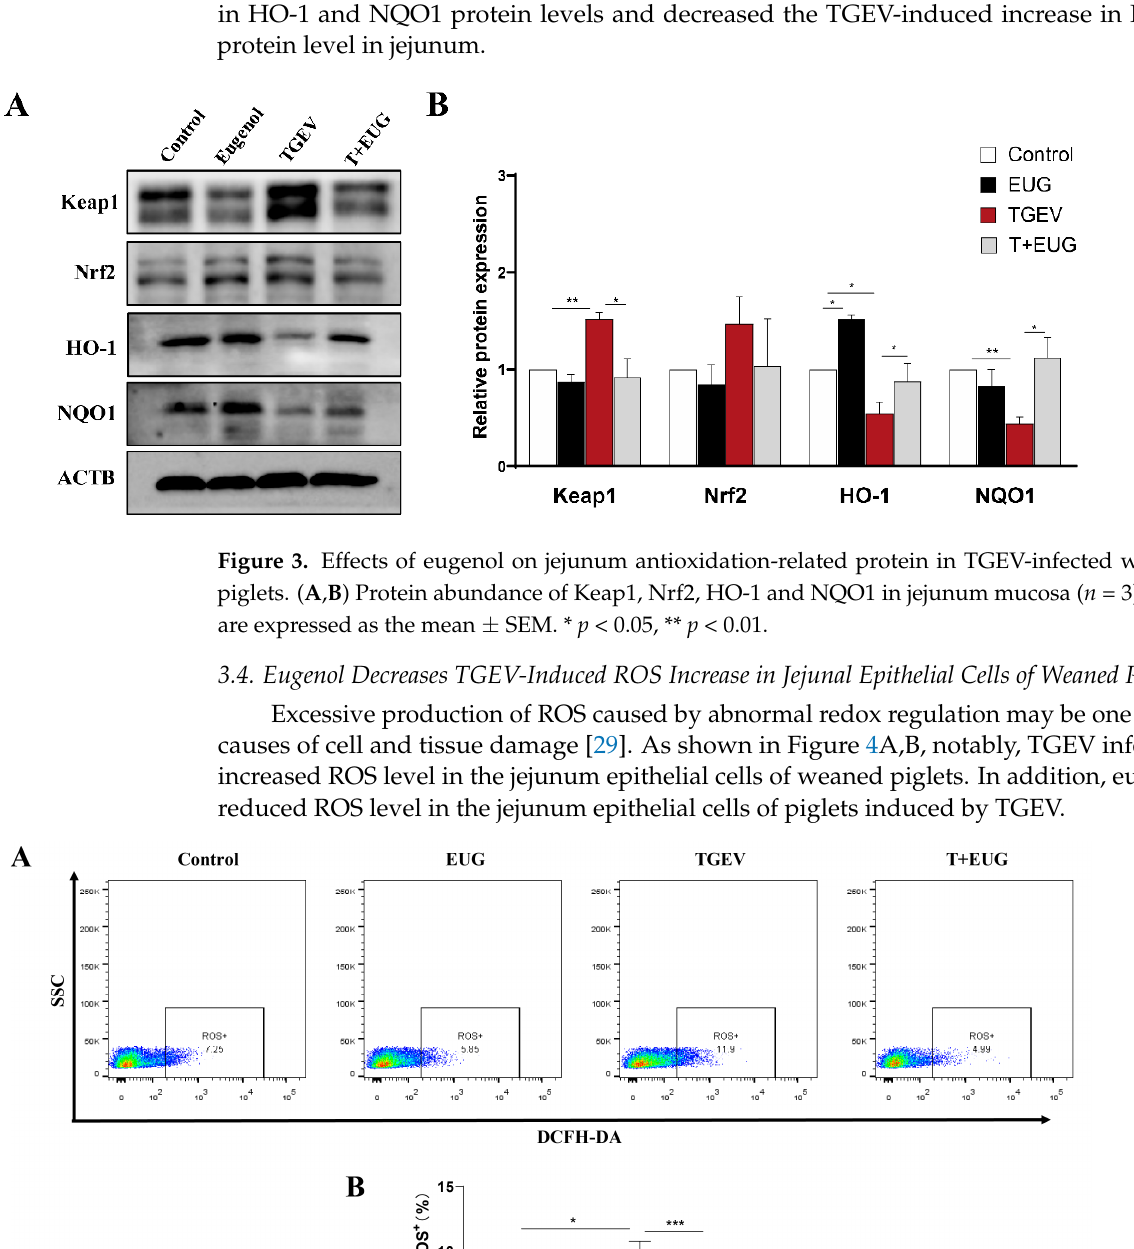
Figure 2. Effects of eugenol on jejunum antioxidation-related genes in TGEV-infected weaned pig- lets. ( A – D ) Relative mRNA expressions of Keap1, Nrf2, HO-1 and NQO1 in the jejunum mucosa ( n = 6–8). Data are expressed as the mean ± SEM. * p < 0.05, ** p < 0.01.